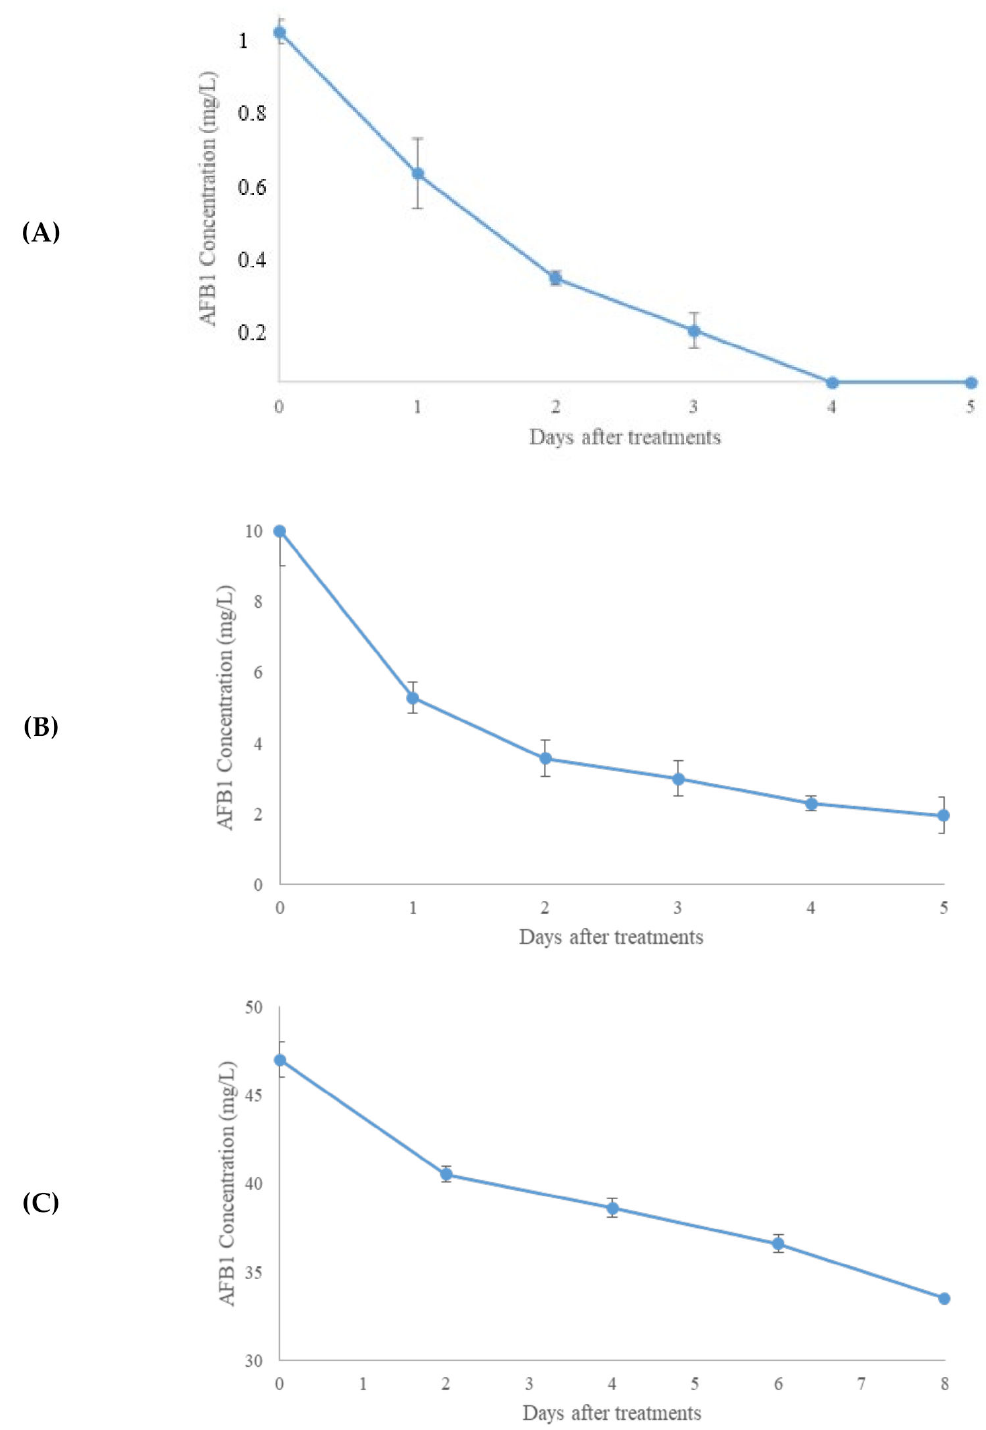
Figure 3. Kinetics degradation of Aflatoxin B1 (AFB1) at different concentrations (0.001 mg/L ( A ), 0.01 mg/L ( B ), and 0.1 mg/L ( C )) after treatment with T. afroharzianum strain T22 culture filtrates. Error bars represent the standard deviation, and the significant difference was p <